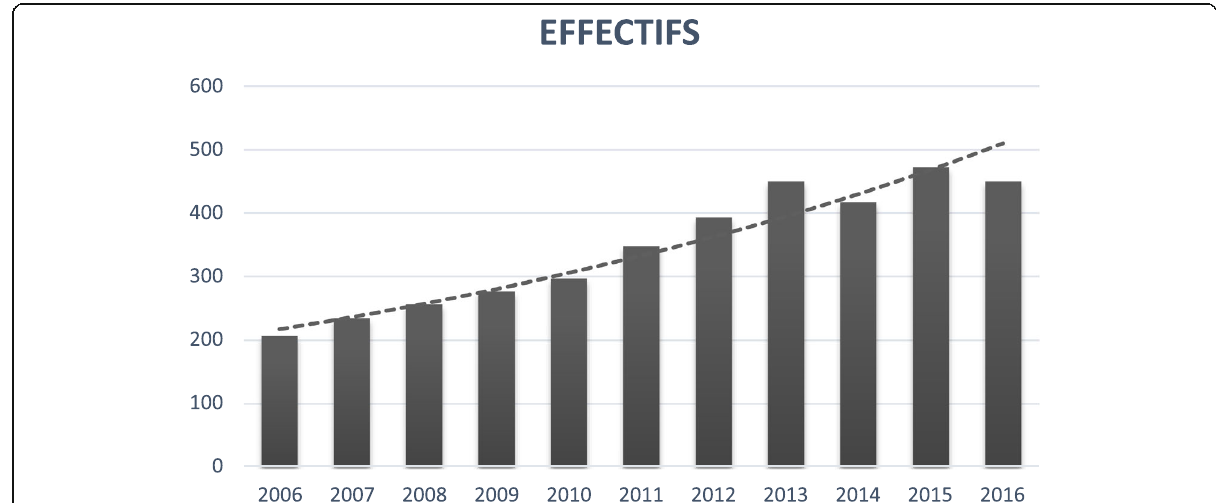
Fig. 1 Annual evolution of the number of patients visiting the psychiatric ward of Ibn Baja Taza Hospital between 2006 and 2016 (---, trend